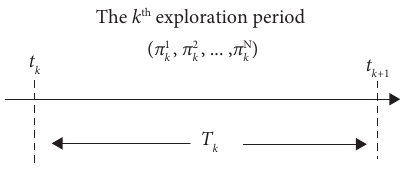
Figure 3: Te k th exploration